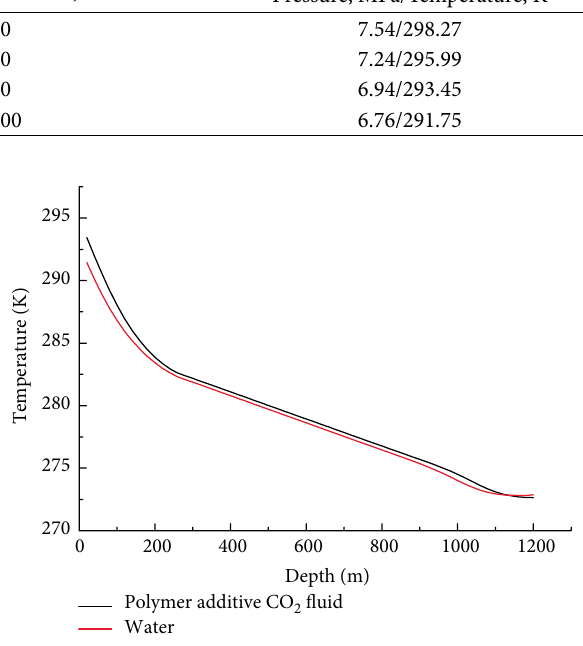
Figure 6: The annulus temperature distribution comparison between the polymer additive CO fluid and water as drilling 2